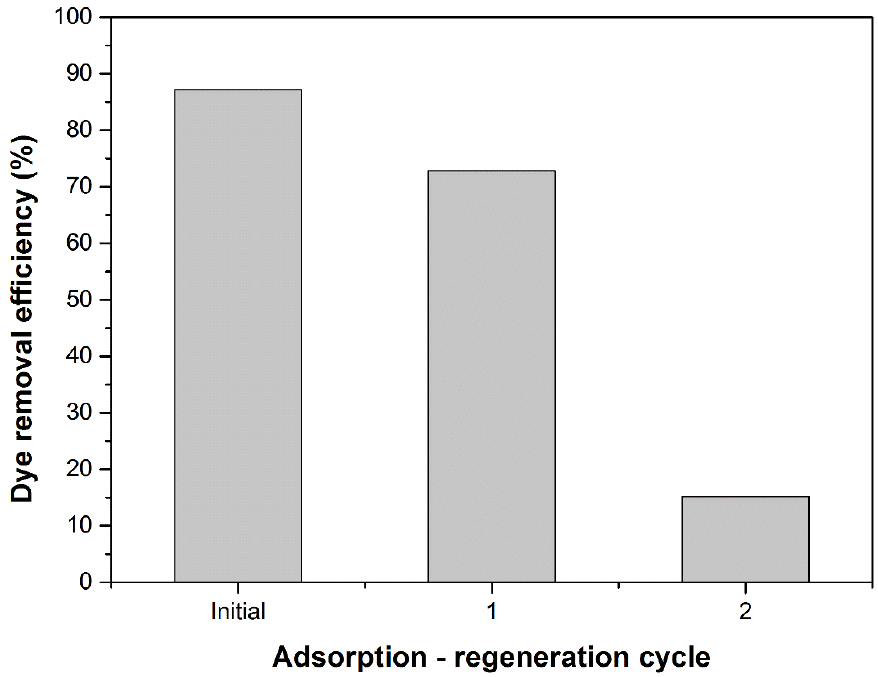
Figure 10. Dye removal efficiency after each adsorption-regeneration cycle.